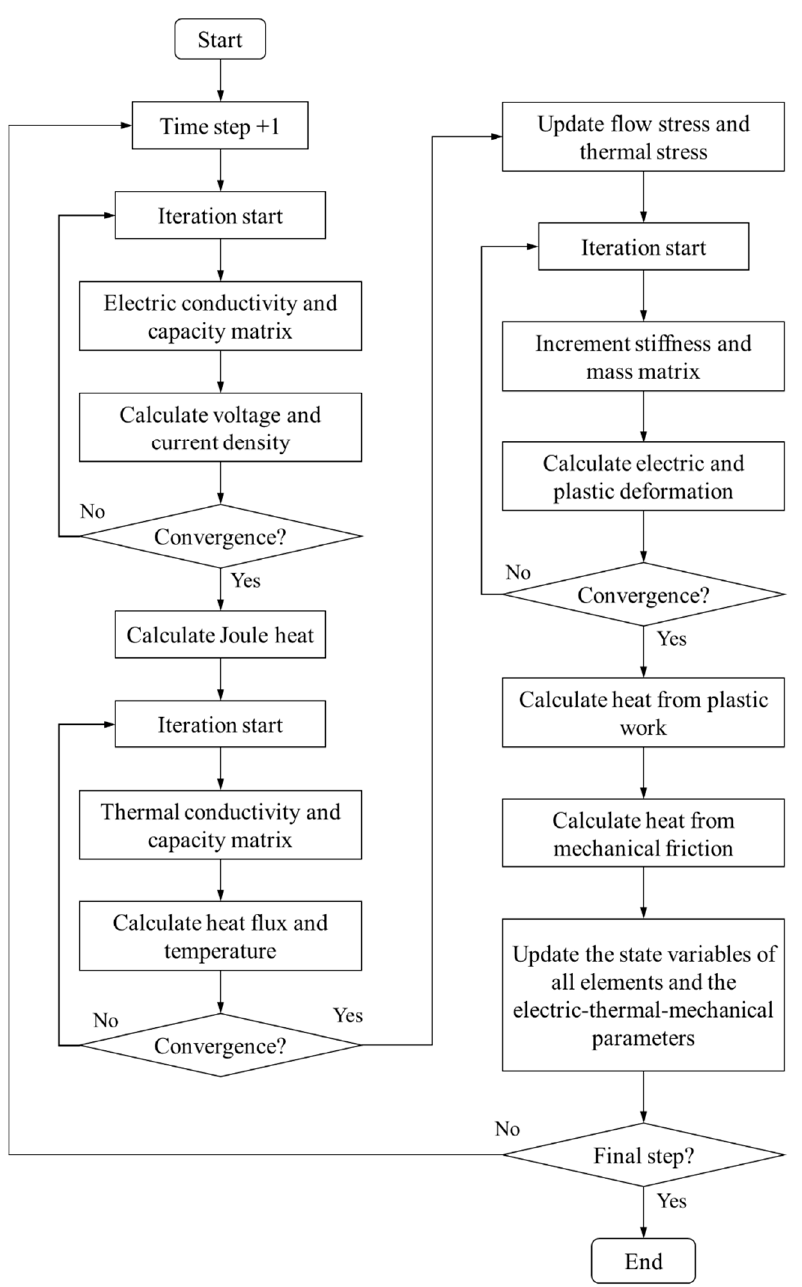
Figure 4. Computing procedures of electric-thermal-mechanical multi-field coupling analysis pro-